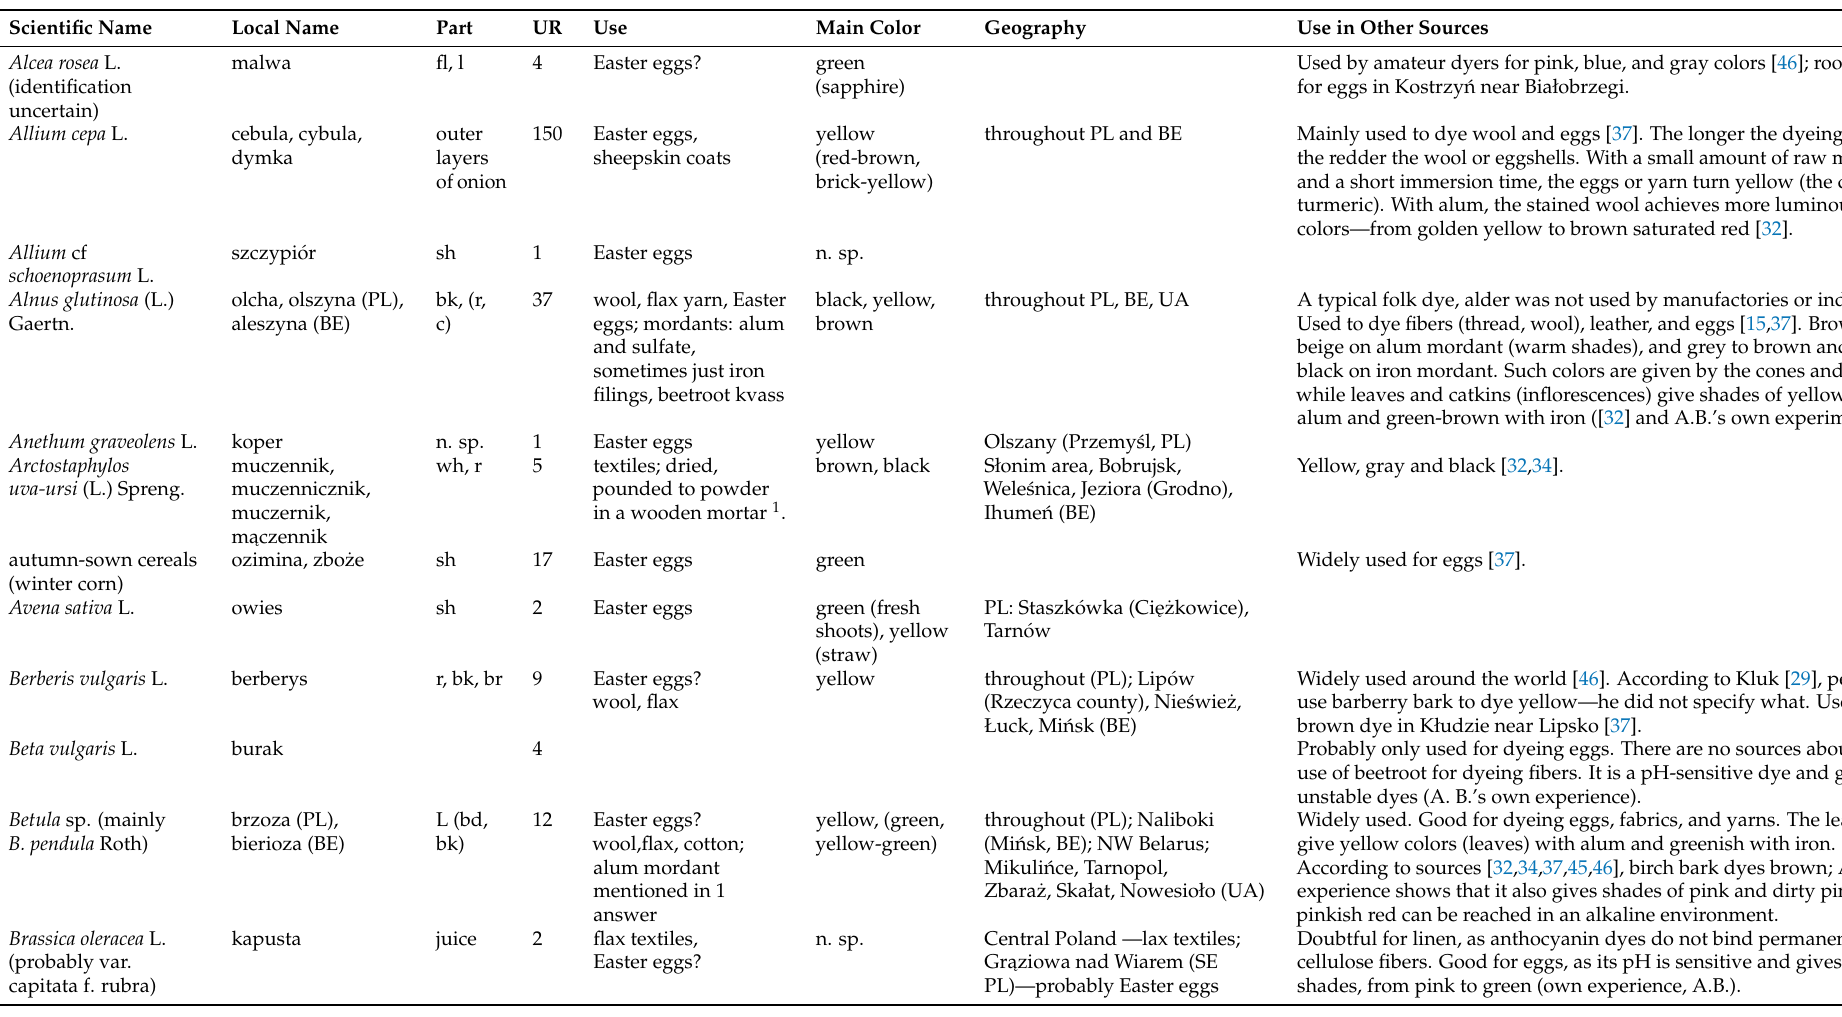
Table 1. Natural dyes recorded by Rostafi´nski in